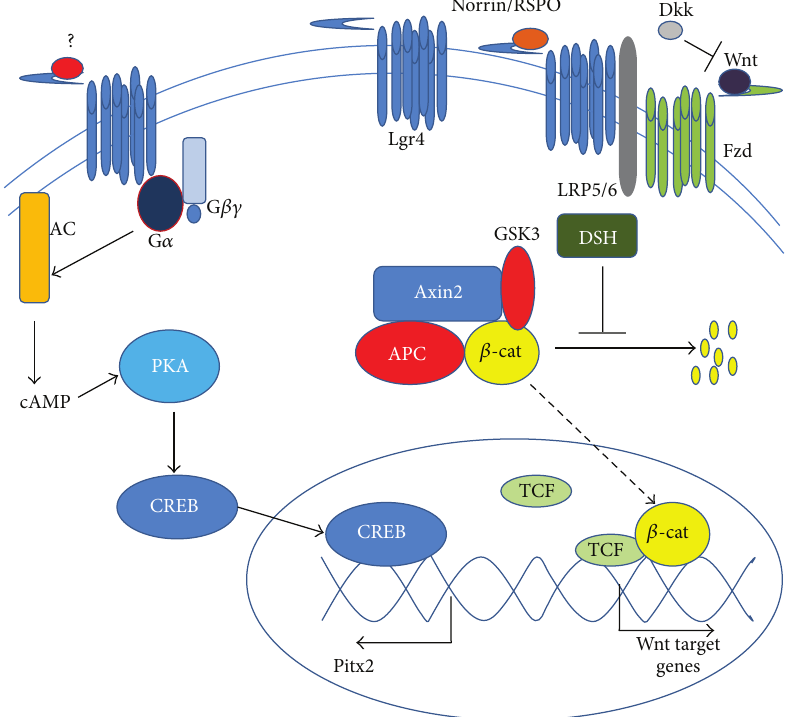
Figure 1: Signaling pathways downstream of Lgr4. Left: binding of unknown ligands (?) leads to G 𝛼 resulting increase in intracellular cyclic AMP levels (cAMP). Elevated cAMP activates protein kinase A (PKA), which phosphorylates CREB inducing its nuclear translocation and regulation of CRE target genes such as Pitx2 . Right: Norrin or R-spondin (Norrin/RSPO) binding to Lgr4 augments the response of Frizzled (Fzd) and LRP5/6 to Wnt binding, leading to activation of Disheveled (DSH). DSH blocks the GSK3/Axin2/APC-mediated degradation of 𝛽 -catenin ( 𝛽 -cat), allowing 𝛽 -catenin accumulation and nuclear translocation (dashed arrow) where 𝛽 -cat binds TCF/LEF (TCF) family transcription factors to regulate Wnt target gene expression. Dikkopf (Dkk) is a competitive inhibitor of Wnt binding to